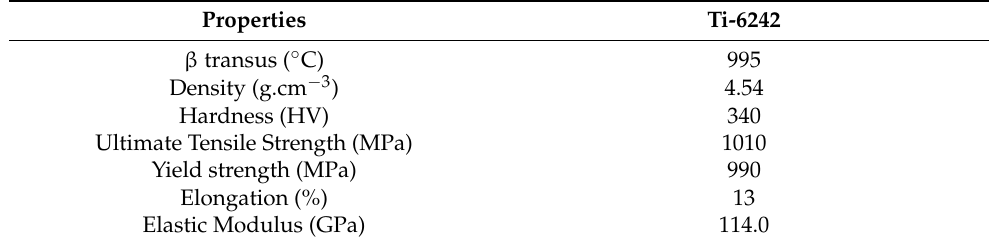
Table 2. Typical properties of Ti-6242 PM [41].